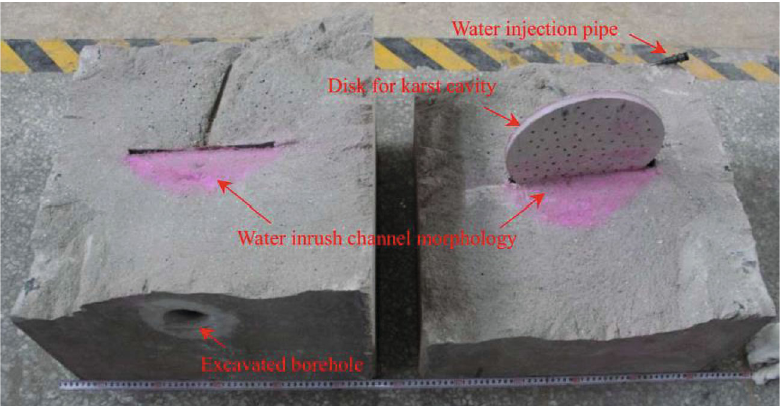
Figure 13: The shape of the water channel.